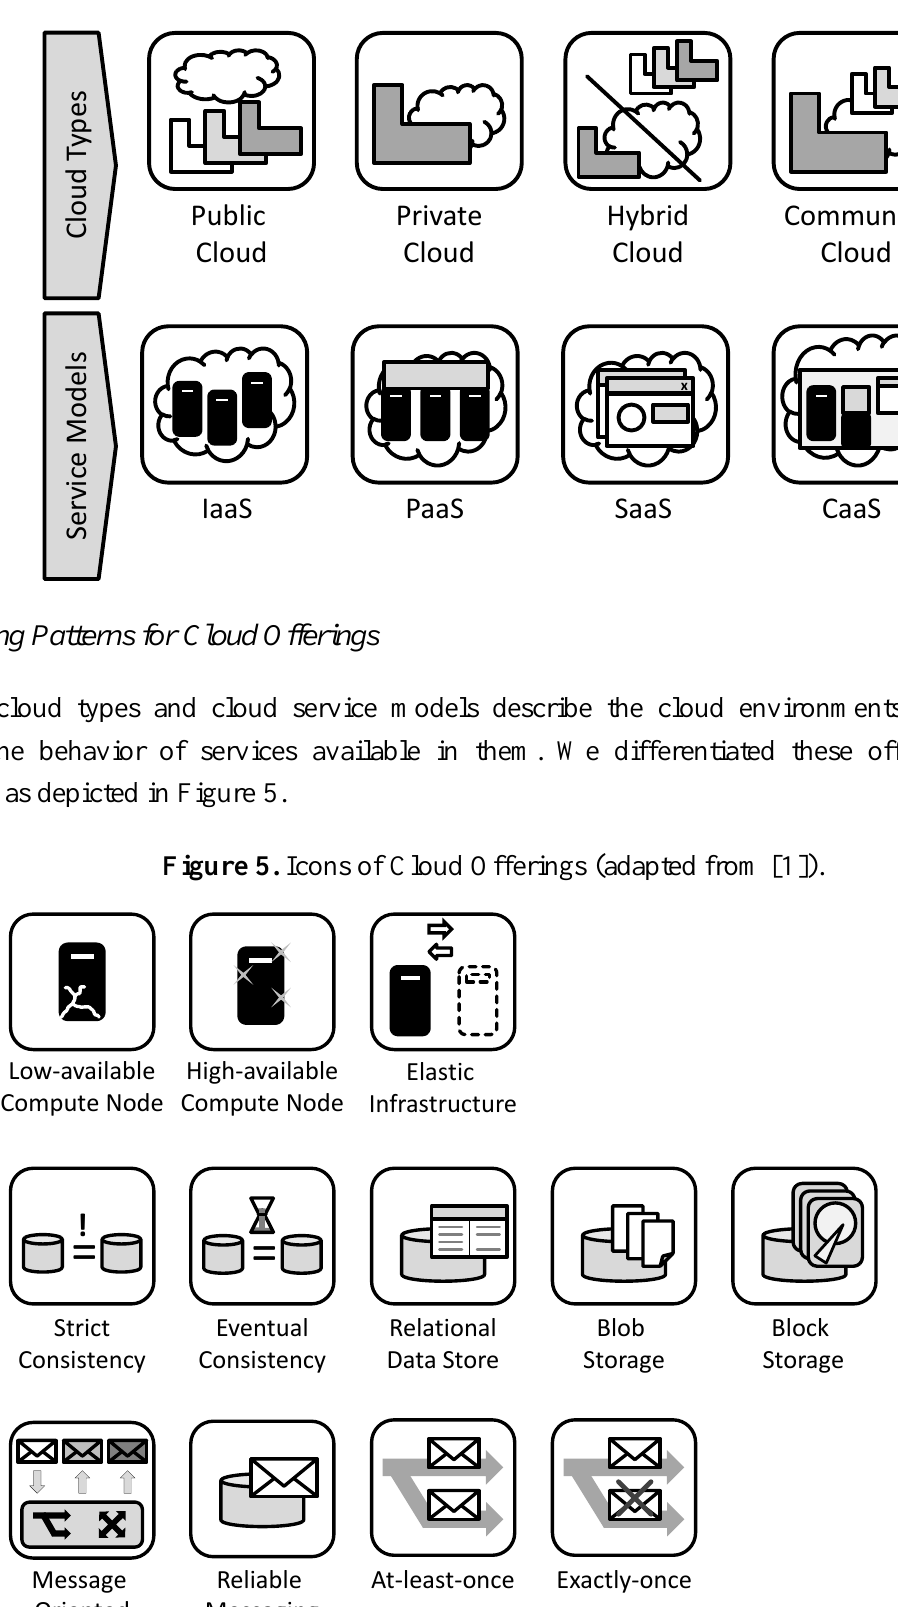
Figure 4. Icons of the Cloud Types and Cloud Service Model Patterns (adapted from [1]).